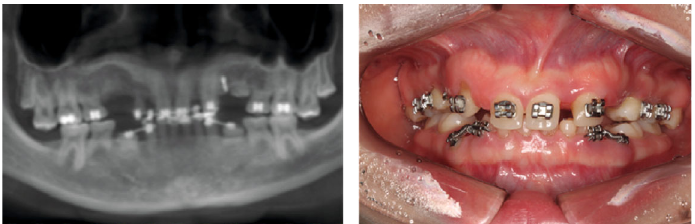
Figure 1: Panoramic radiograph (a) and intraoral buccal view, showing permanent tooth absences and presence of several deciduous teeth.